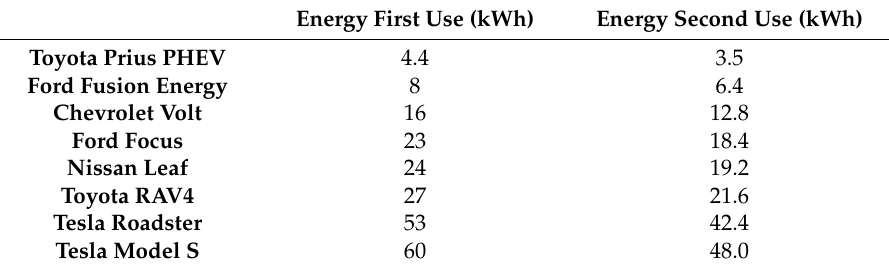
Table 1. Energy storage of battery packs (PHEV, EV, and HEV models) [10–14]. Energy First Use